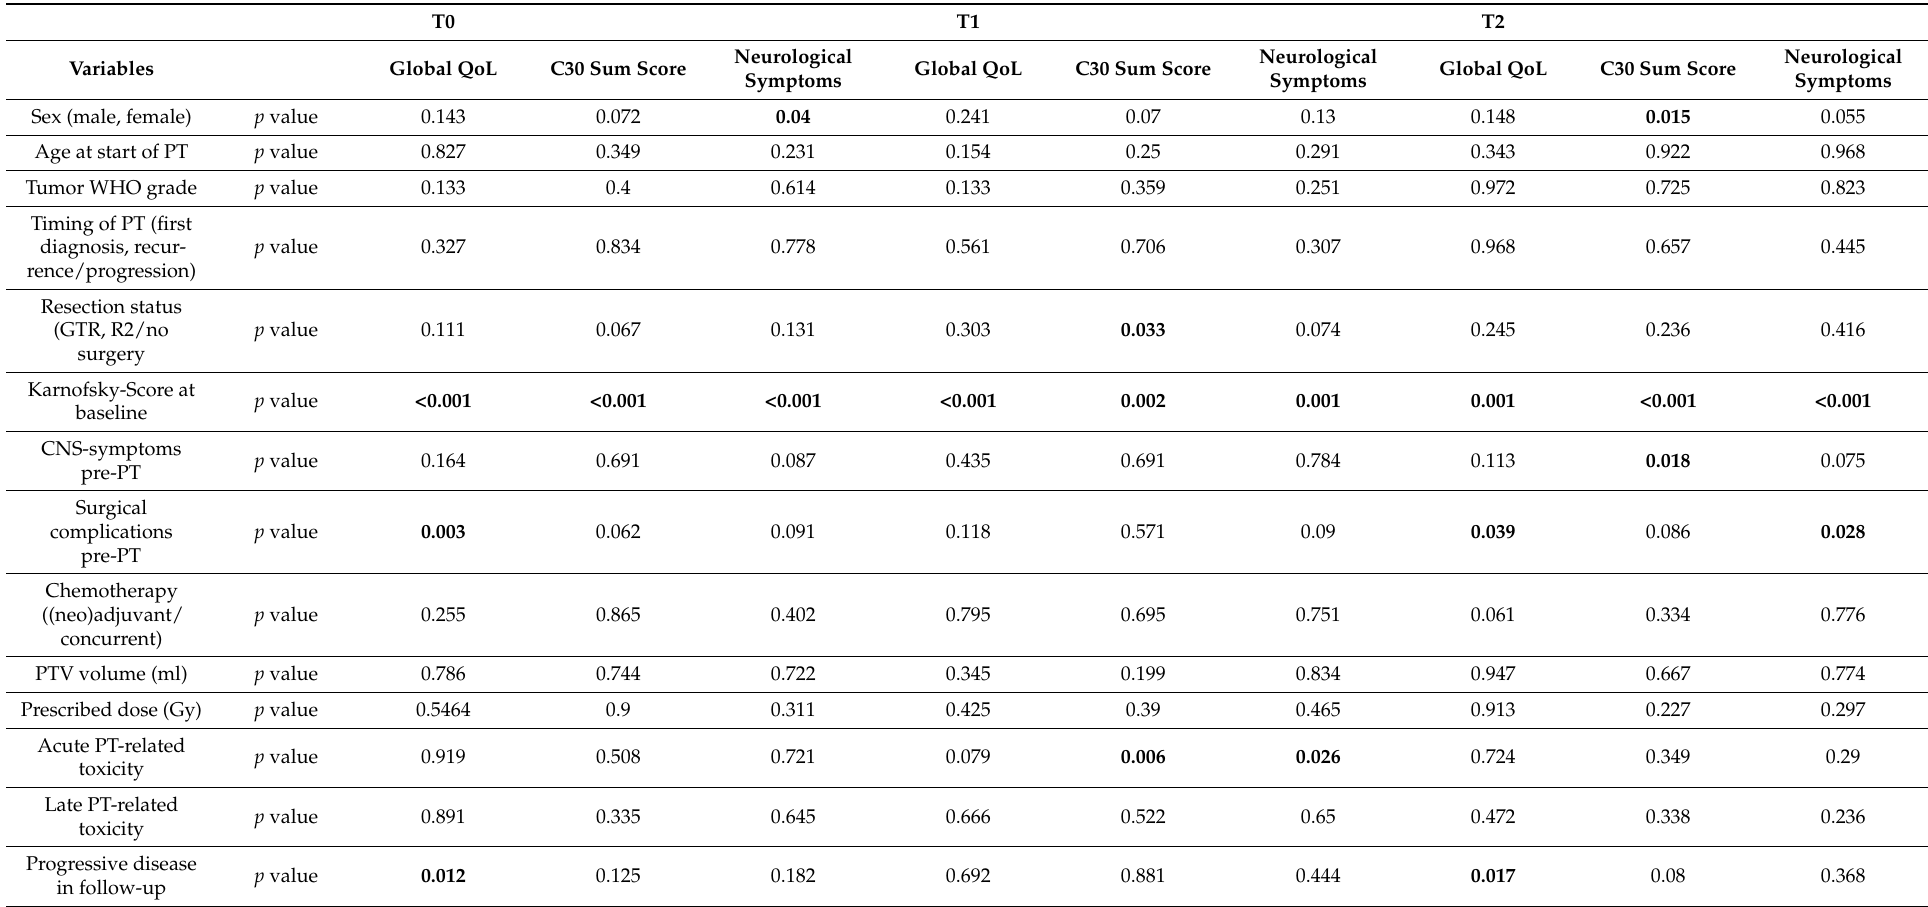
Table 2. The association between EORTC QLQ-C30 global QoL, C30 SumSC and BN20 neurological symptom score and clinical parameters. PT = proton therapy, GTR = gross